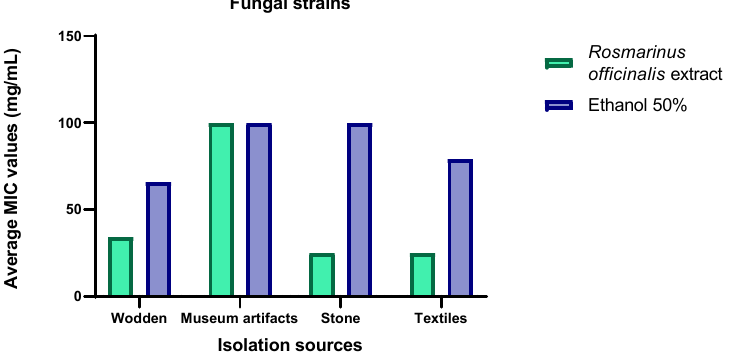
Figure 3. Graphic representation of the average values of the minimal inhibitory concentration (MIC) of R. officinalis hydro-alcoholic extract against fungal strains expressed by the isolation sources.